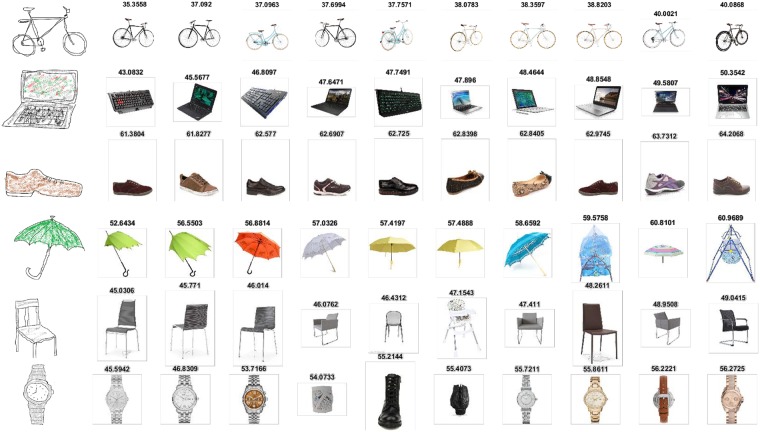
Retrieval performance in response to partially colored sketches.